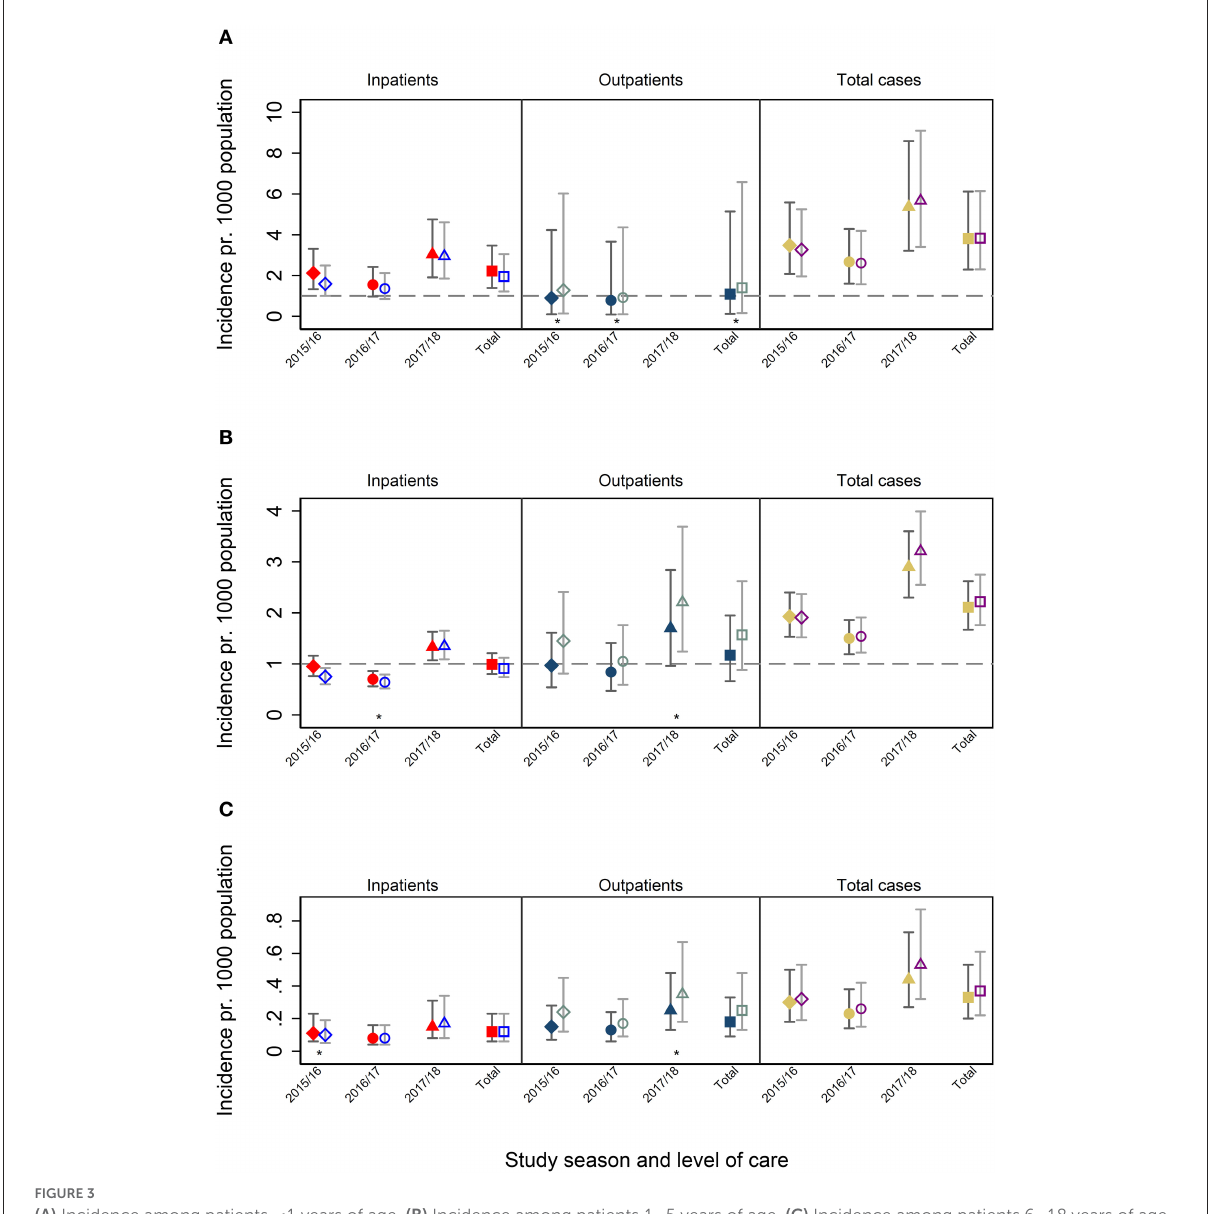
FIGURE3 (A) Incidence among patients < 1 years of age. (B) Incidence among patients 1–5 years of age. (C) Incidence among patients 6–18 years of age. Filled symbols represent national estimates, hollow symbols represent the population living in the catchment area of hospitals participation in